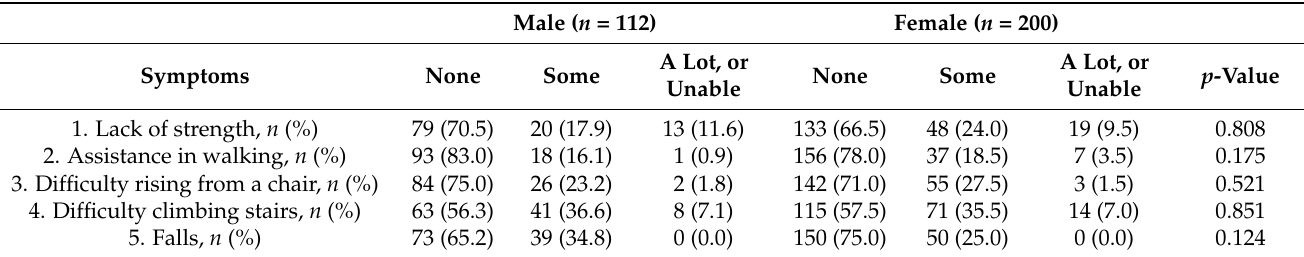
Table 2. Prevalence of symptoms of sarcopenia evaluated through the SARC-F questionnaire. Male ( n = 112) Female ( n = 200) A Lot, or A Lot, or p Symptoms None Some None Some Unable Unable